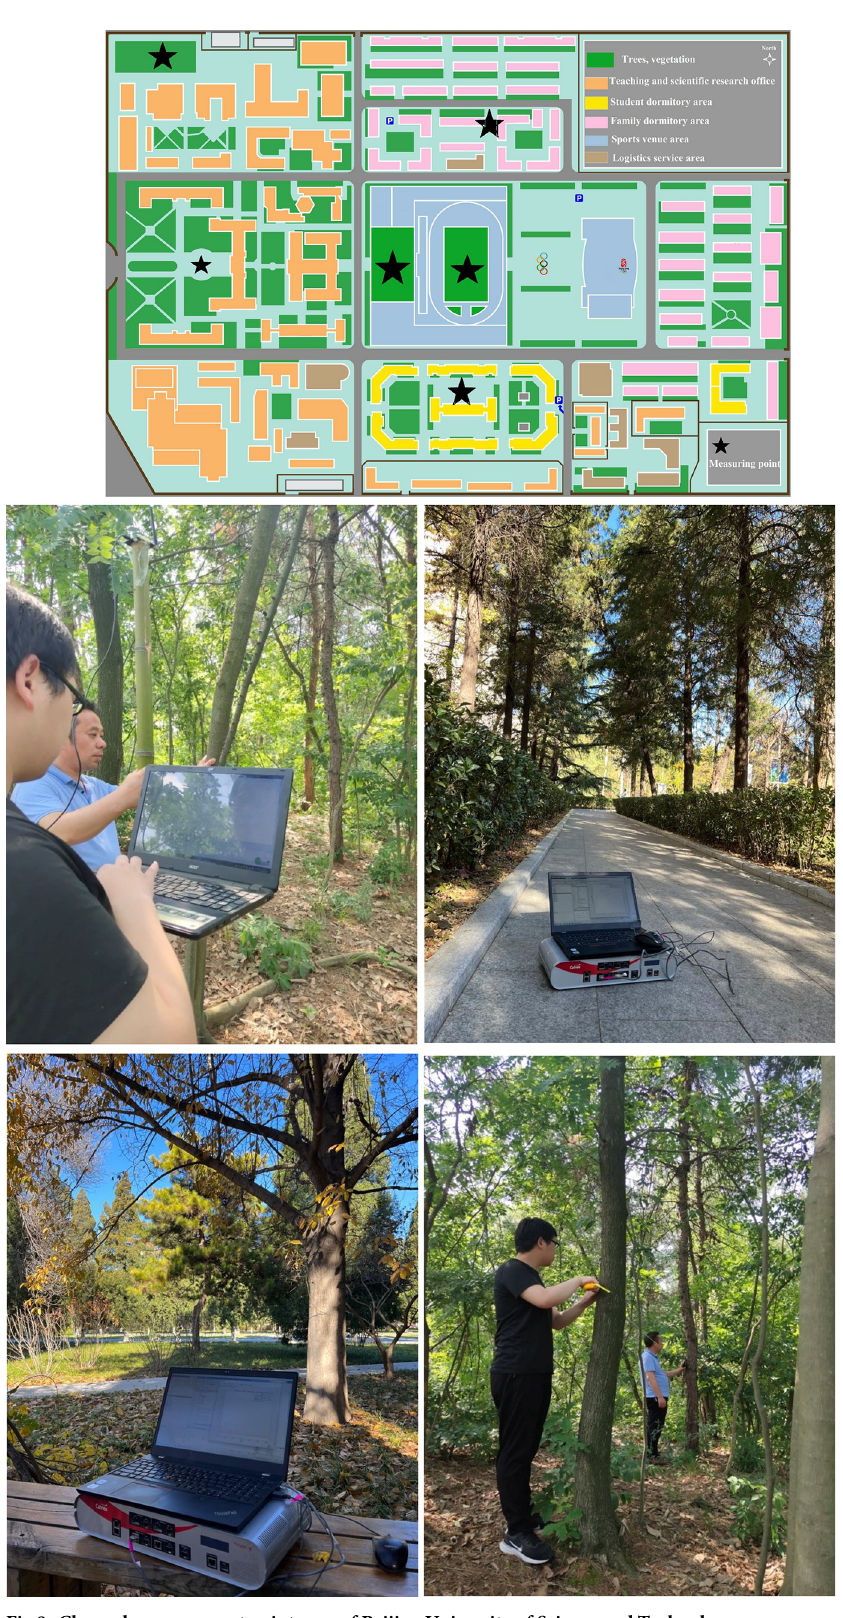
Fig 9. Channel measurement point map of Beijing University of Science and